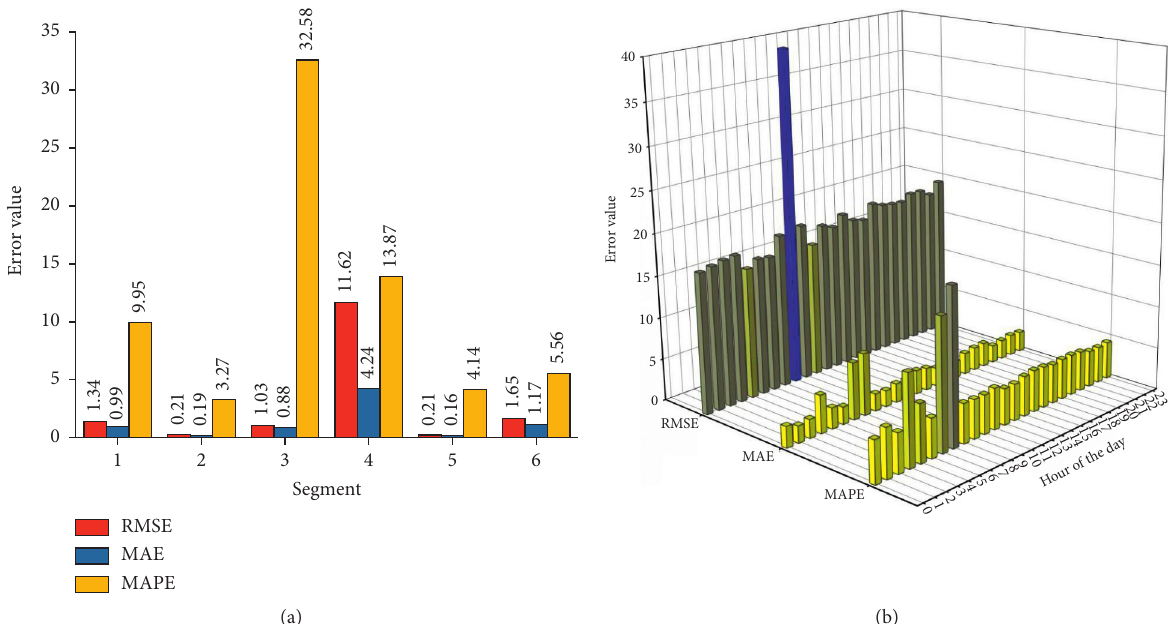
Figure 6: Forecast errors for LSTM-CNN by different segments and hours of the day.